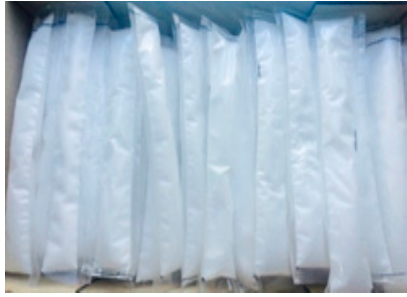
Figure 1. Packed phase-change material (PCM) in nylon plastic bags.